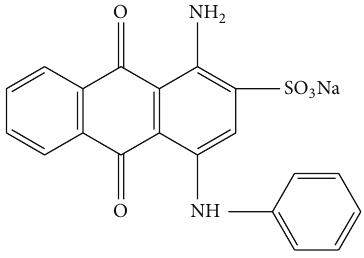
Figure 1: Chemical structure of Acid Blue